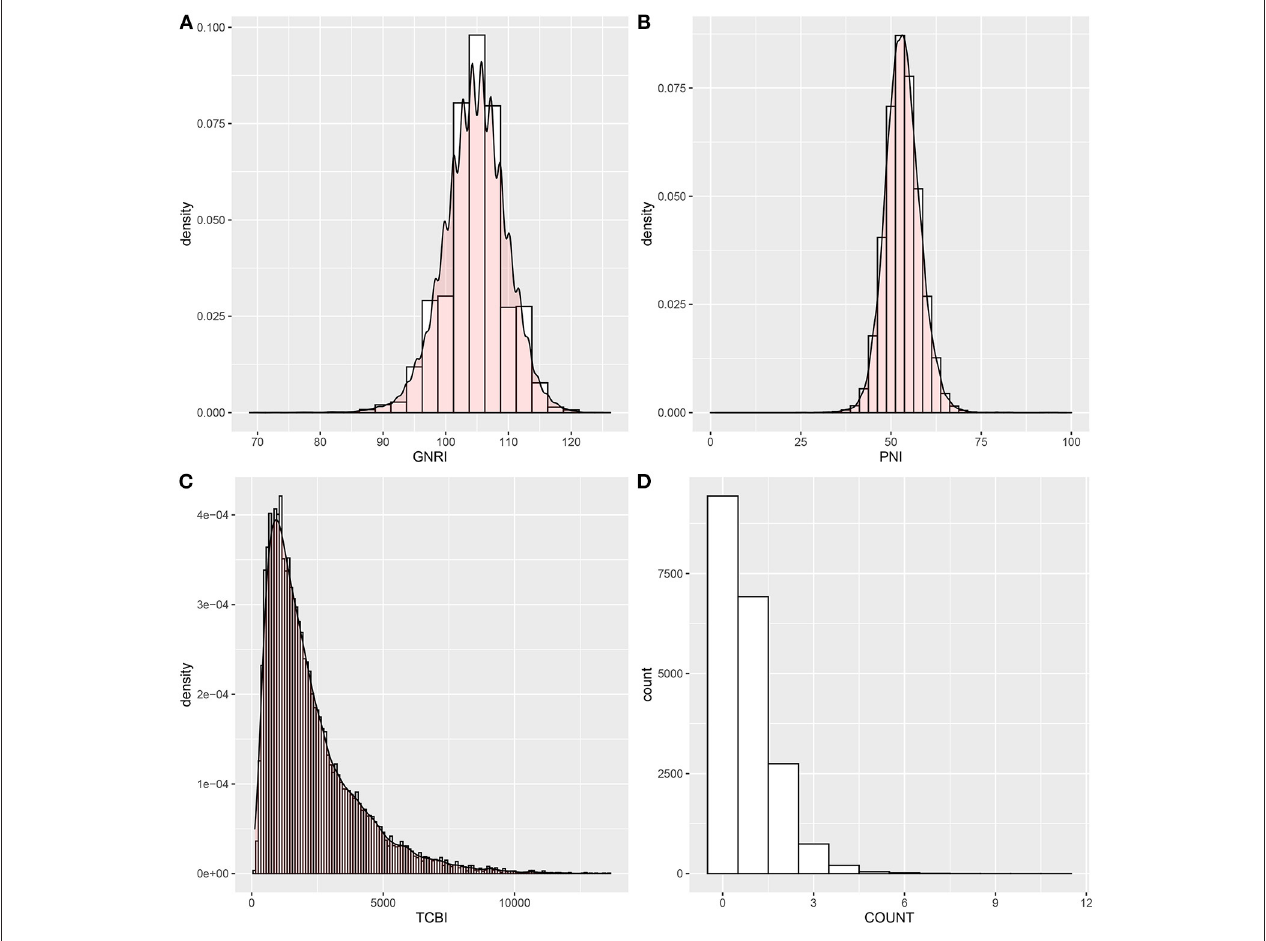
FIGURE 2 | Histograms show the population distribution of nutritional scores. (A) GNRI; (B) PNI; (C) TCBI; (D) COUNT score. PNI, Prognostic Nutritional Index; GNRI, Geriatric Nutritional Risk Index; CONUT score, Controlling Nutritional Status score; TCBI, Triglycerides × Total Cholesterol × Body Weight